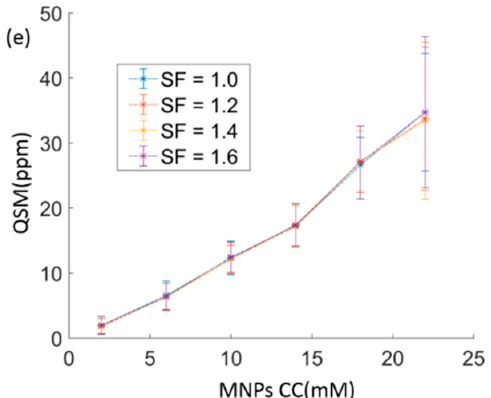
Figure 4. Cones-QSM with four different stretching factors of ( a ) 1.0, ( b ) 1.2, ( c ) 1.4, and ( d ) 1.6, respectively. The ROI analysis of different iron concentrations is shown in ( e ). Similar UTE-QSM values were achieved with different stretching factors, except for the tube with the highest iron concentration of 22 mM, which showed lower QSM values and greater standard deviations with higher stretching factors.